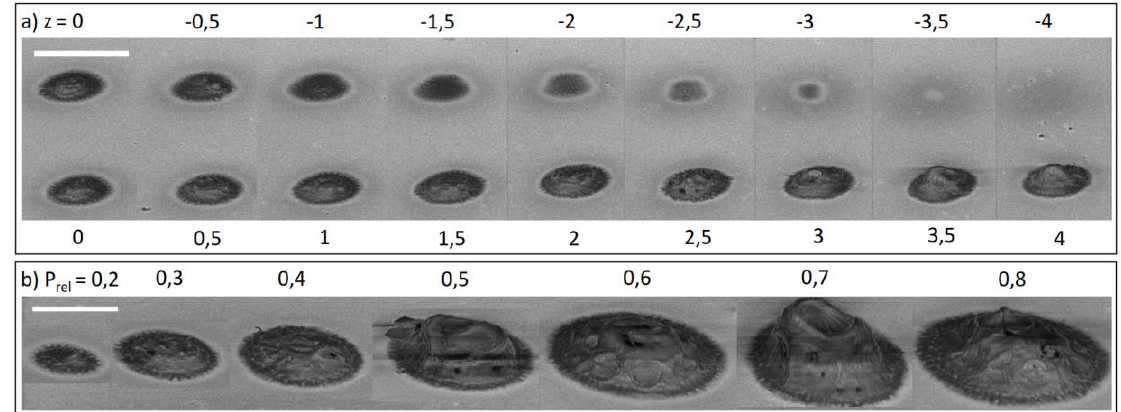
Figure 4. ( a ) Offset screening with values given in µm. Offset = 0 is at the automatic adjusted interface. At higher z-values the focus point moves into the surface. The scale bar is 5 µm; ( b ) screening of different P rel settings ranging from 0.2 to 0.8. Scale bar is 3 µm. All samples were prepared on reflective chromium from R1. The interface (z = 0) was determined by the interferometry-based interface finder of the DLW system.